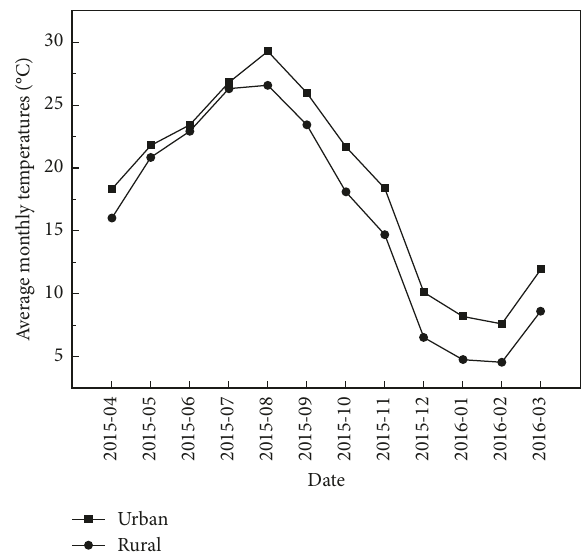
Figure 8: Average monthly temperatures for urban and rural soils in the depth ranges of 0–40